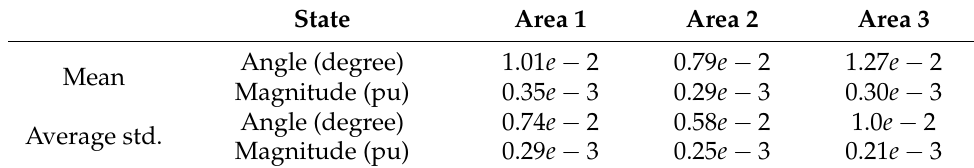
Table 4. Statistic metric per state per area on IEEE -118 (local states